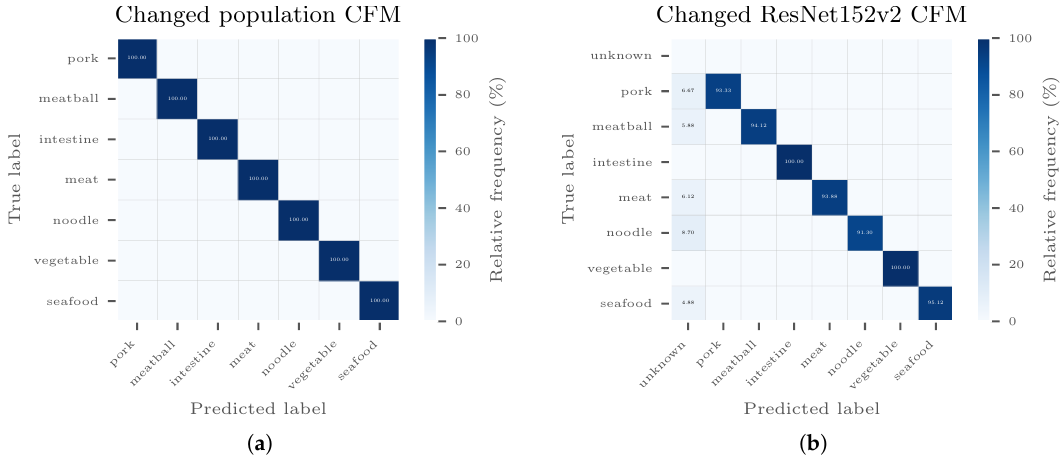
Figure A8. The population ( a ) and ResNet ( b ) CFM after applying CRT. CFMs are obtained from the ASIA population and VireoFood-172